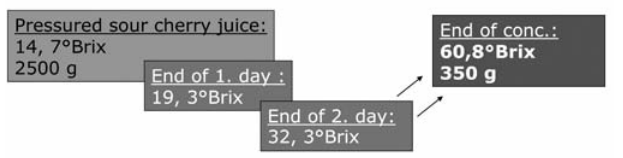
Figure 3. Concentration steps of sour cherry juice by osmotic